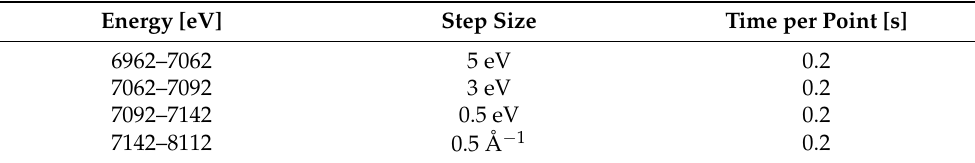
Table 8. Step scan parameters used in X-ray absorption spectroscopy. Energy [eV] Step Size Time per Point [s] 6962–7062 5